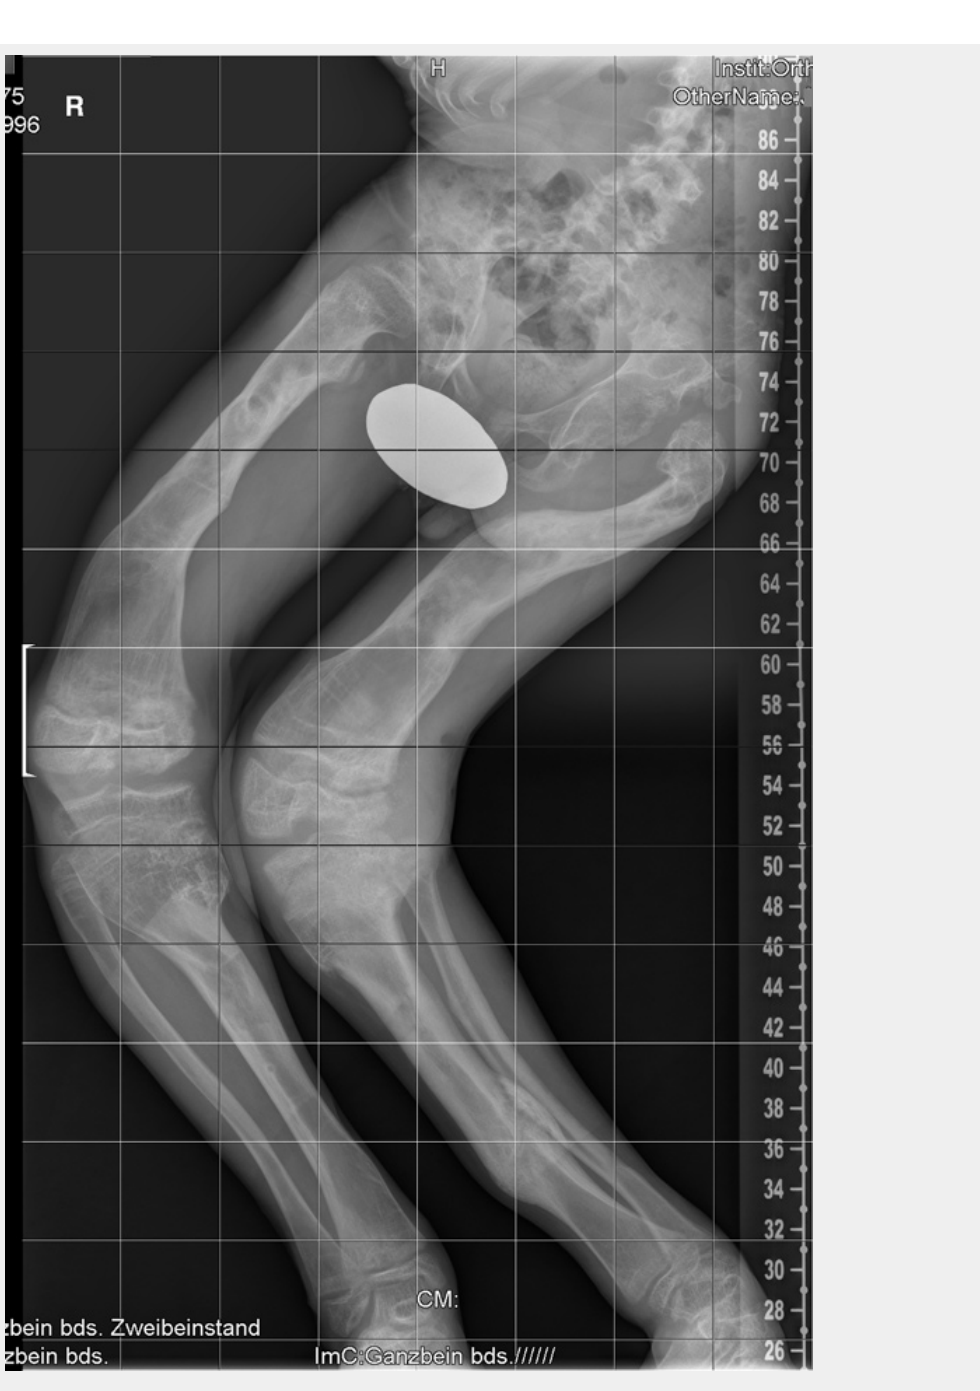
Figure 1 AP-view weight bearing X-ray of the patient before starting correction showed, at the pelvis and the femora, severe dysplasia of the capital femoral epiphyses, the acetabulae and the hypoplastic pelvis associated with bowing of the upper femoral shaft and Erlenmeyer flask appearance of the lower femora. Note the windswept deformity which presents abnormal valgus deformity in one knee in association with varus deformity in the other. The inferior femoral and superior tibial epiphyses look enlarged and severely